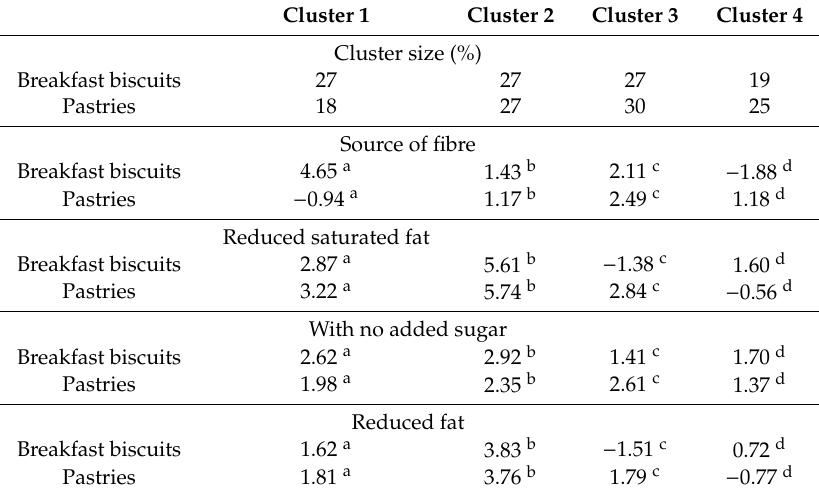
Table 7. Segmentation of consumer according to nutritional claim importance.